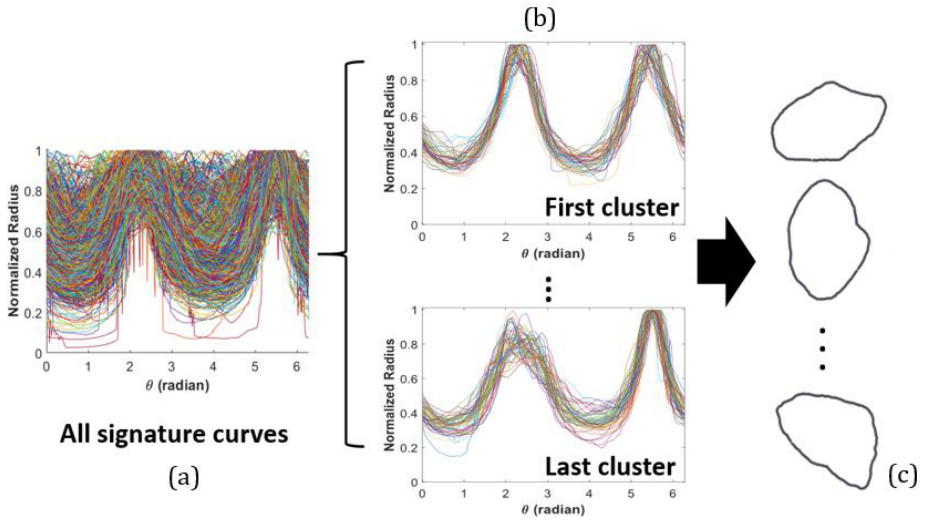
Figure 3. Conceptual process of image analysis and functional data clustering for random shape aggregate models (IFAM): ( a ) all signature curves obtained by digital image processing (DIP), ( b